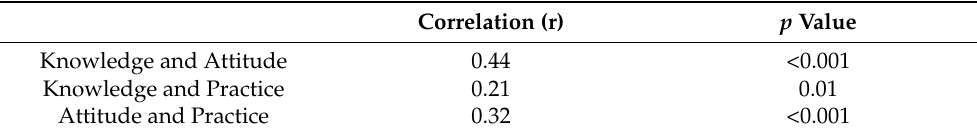
Table 5. Correlations between knowledge, attitude, and practice scores.